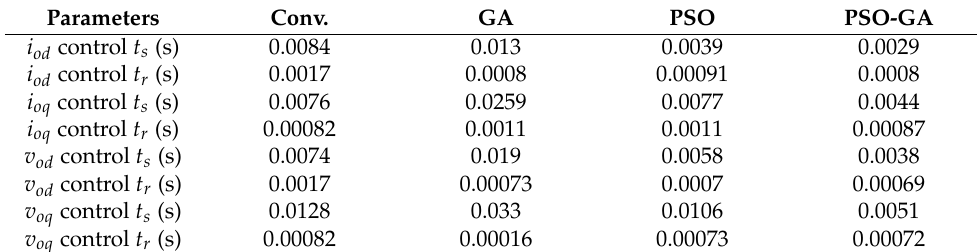
Table 5. The comparison of the PI controllers transient